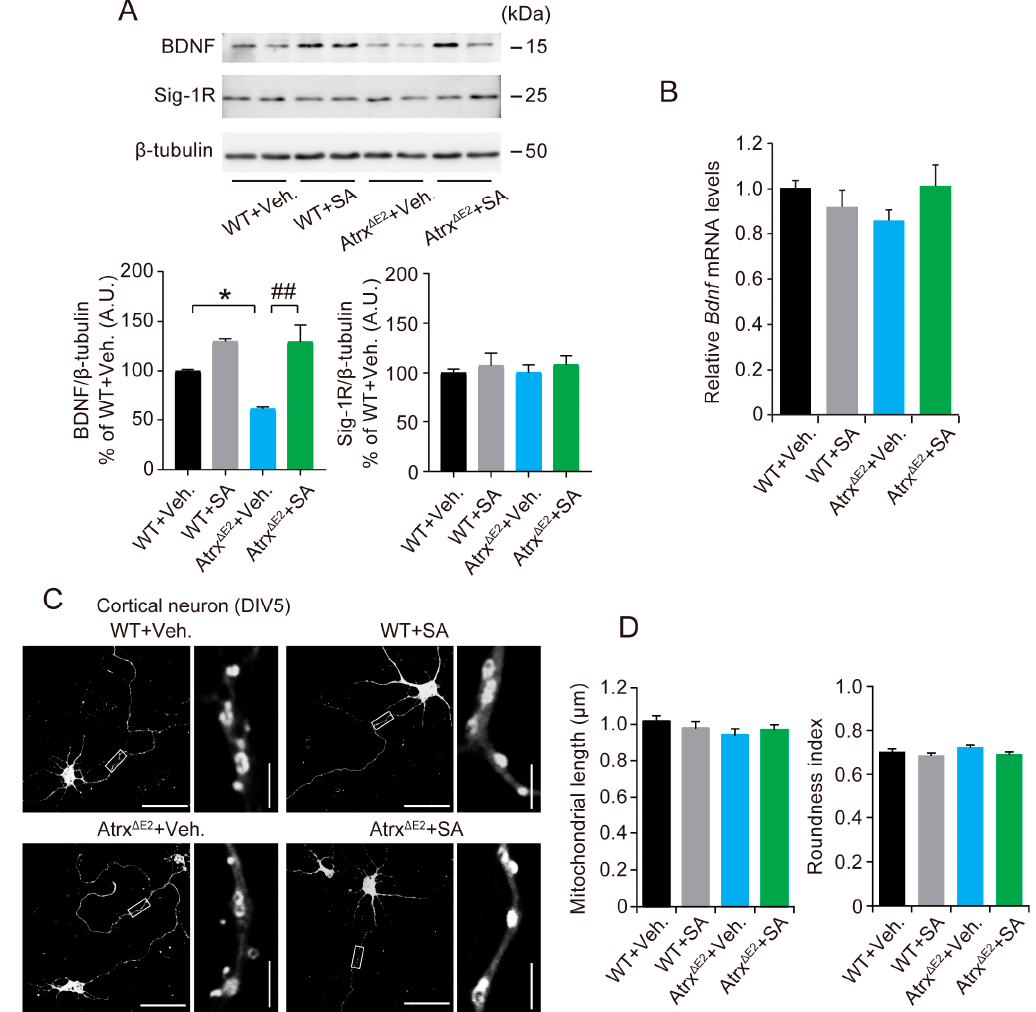
Figure 4. Treatment with SA4503 increases BDNF protein level in Atrx Δ E2 mouse brain. ( A ) Representative immunoblot of mouse medial prefrontal cortex lysates probed with the indicated antibodies (top panel). Densitometry analysis of indicated proteins to β -tubulin (arbitrary units; (A.U.)) (bottom panel). * p < 0.05, versus vehicle-treated WT mice; ## p < 0.01, versus vehicle-treated Atrx ∆